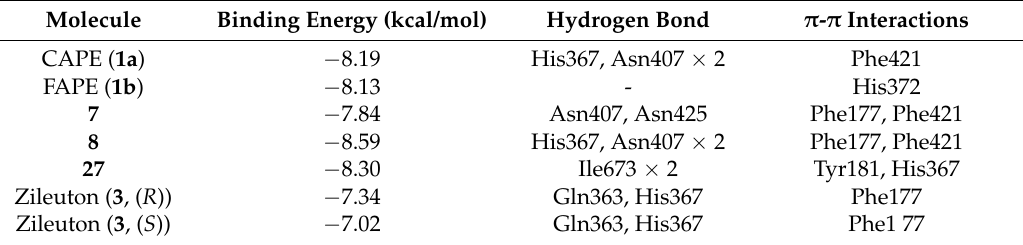
Table 1. Binding energy, bonds, and interactions for individual ligands. Molecule Binding Energy